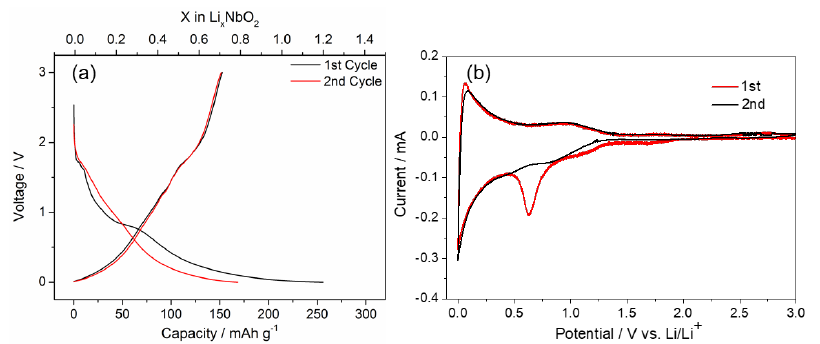
Figure 3. ( a ) Charge and discharge curves and ( b ) cyclic voltammograms of the first and second cycles of pristine NbO 2 .